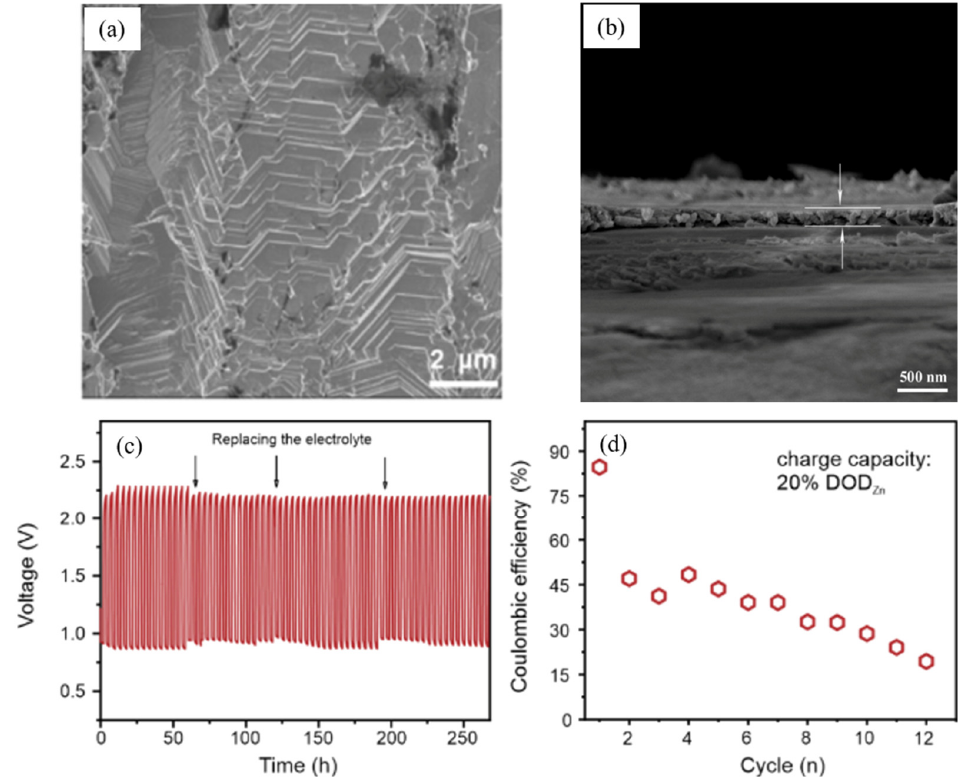
Figure 19. ( a ) A low-magnification SEM image of the [002]-textured zinc foil, ( b ) Cross-sectional SEM image of the cycled zinc showing 140 nm SEI of zinc phosphate ( c ) Cyclization profile of the zinc-O 2 cell (current density of 0.1 mA/cm 2 ), ( d ) Coulombic efficiency of the zinc-O 2 cell with the constant charge capacity of 6 mAh/cm 2 (20% DoD Zn ) at a current density of 1.1 mA/cm 2 , [38]. Reprinted with permission from Ref. [38], Copyright 2022, Elsevier.